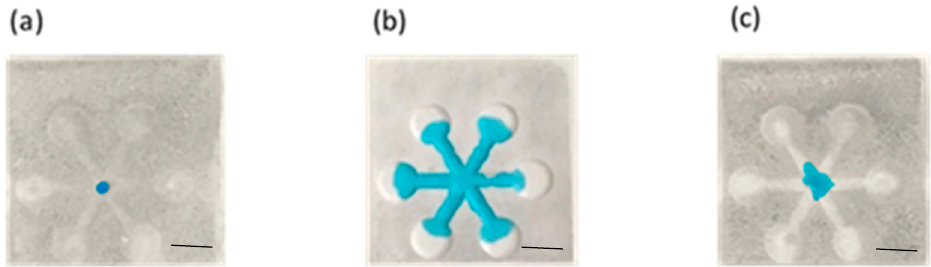
Figure 3. Dispensing ink solution on the embossed filter paper. ( a ) Whatman #1. ( b ) Whatman #3. ( c ) Whatman #4. Scale bar: 4 mm.